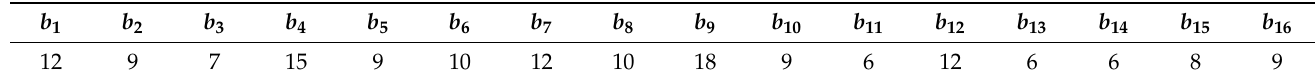
Table 2. Demand of recipients.